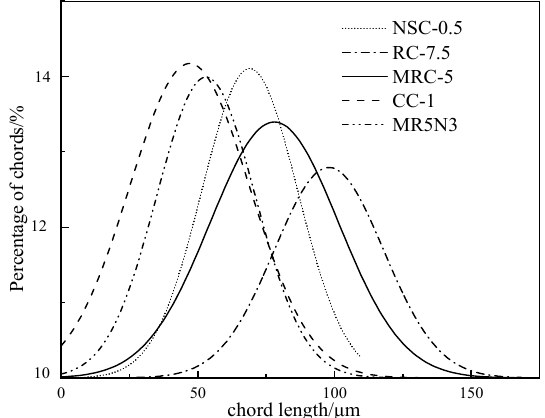
Figure 4. Chord length distribution of pores.